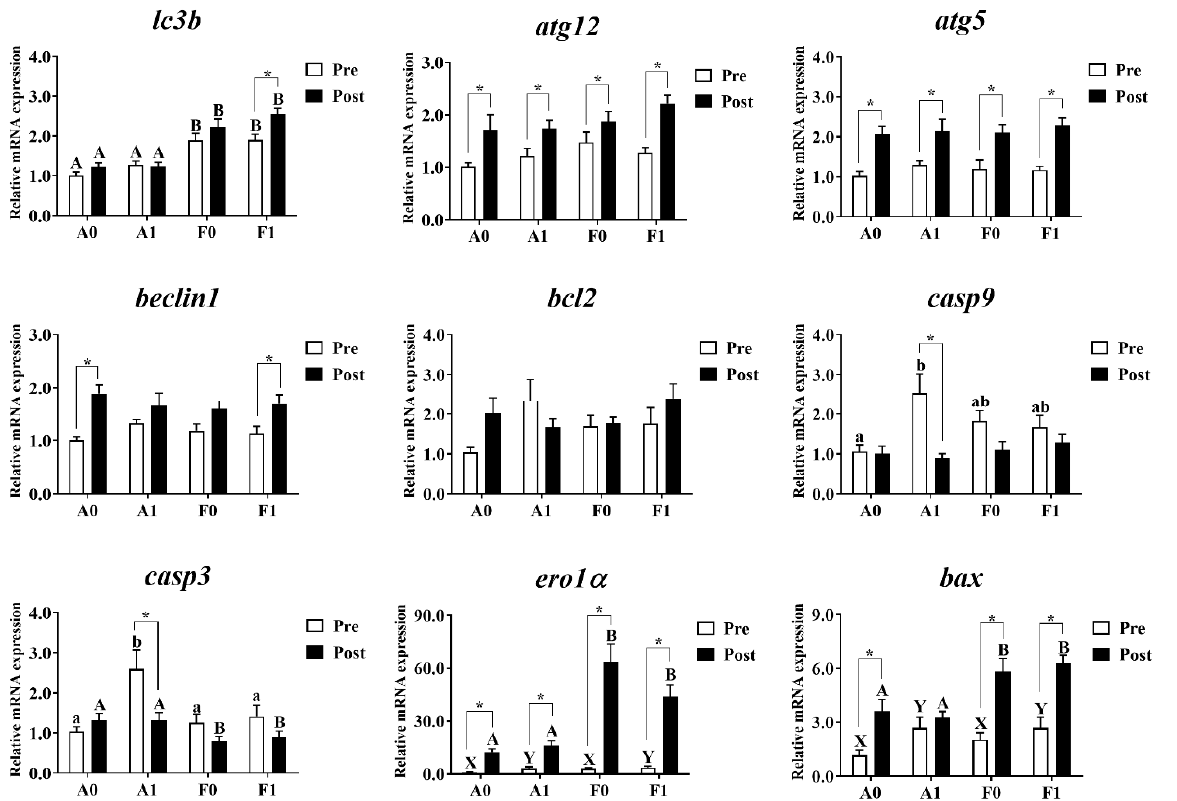
Figure 8. Expression levels of genes related to autophagy and apoptosis in the livers of gibel carp (A and F strains) before cadmium exposure (white bars) and after cadmium exposure (black bars). A0: A strain fed the control diet; A1: A strain fed a diet supplemented with taurine; F0: A strain fed the control diet; F1: A strain fed a diet supplemented with taurine. Bars with different uppercase letters (A, B) represent significant differences between A and F strains ( p < 0.05). Bars with different upper-case letters (X, Y) represent significant differences between the control diet group and the taurine diet group ( p < 0.05). Bars with different lowercase letters (a, b) indicate the interaction effect and represent the differences among all groups ( p < 0.05). Bars with * mean significant changes between before and after cadmium exposure ( p < 0.05).